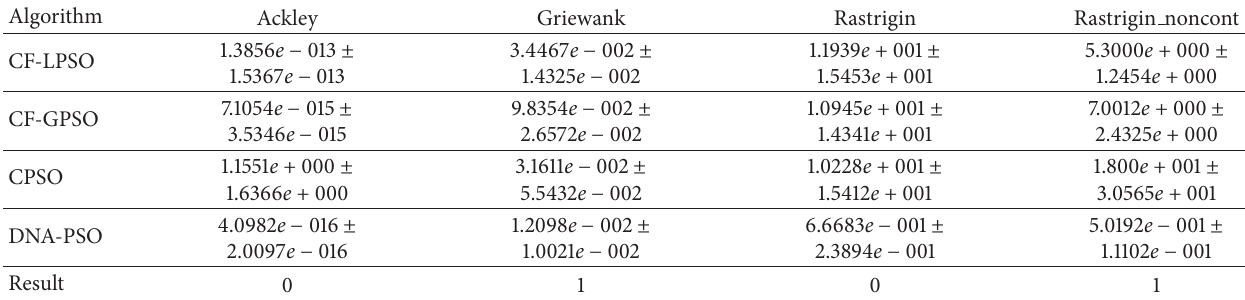
Table 2: Means and confidence interval for rotating function after 6 × 10 4 function